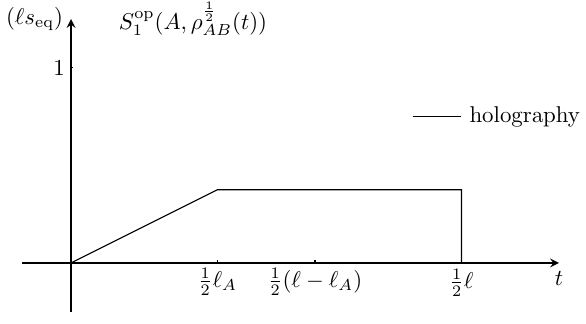
Figure 22 . Results of holographic theory in AdS